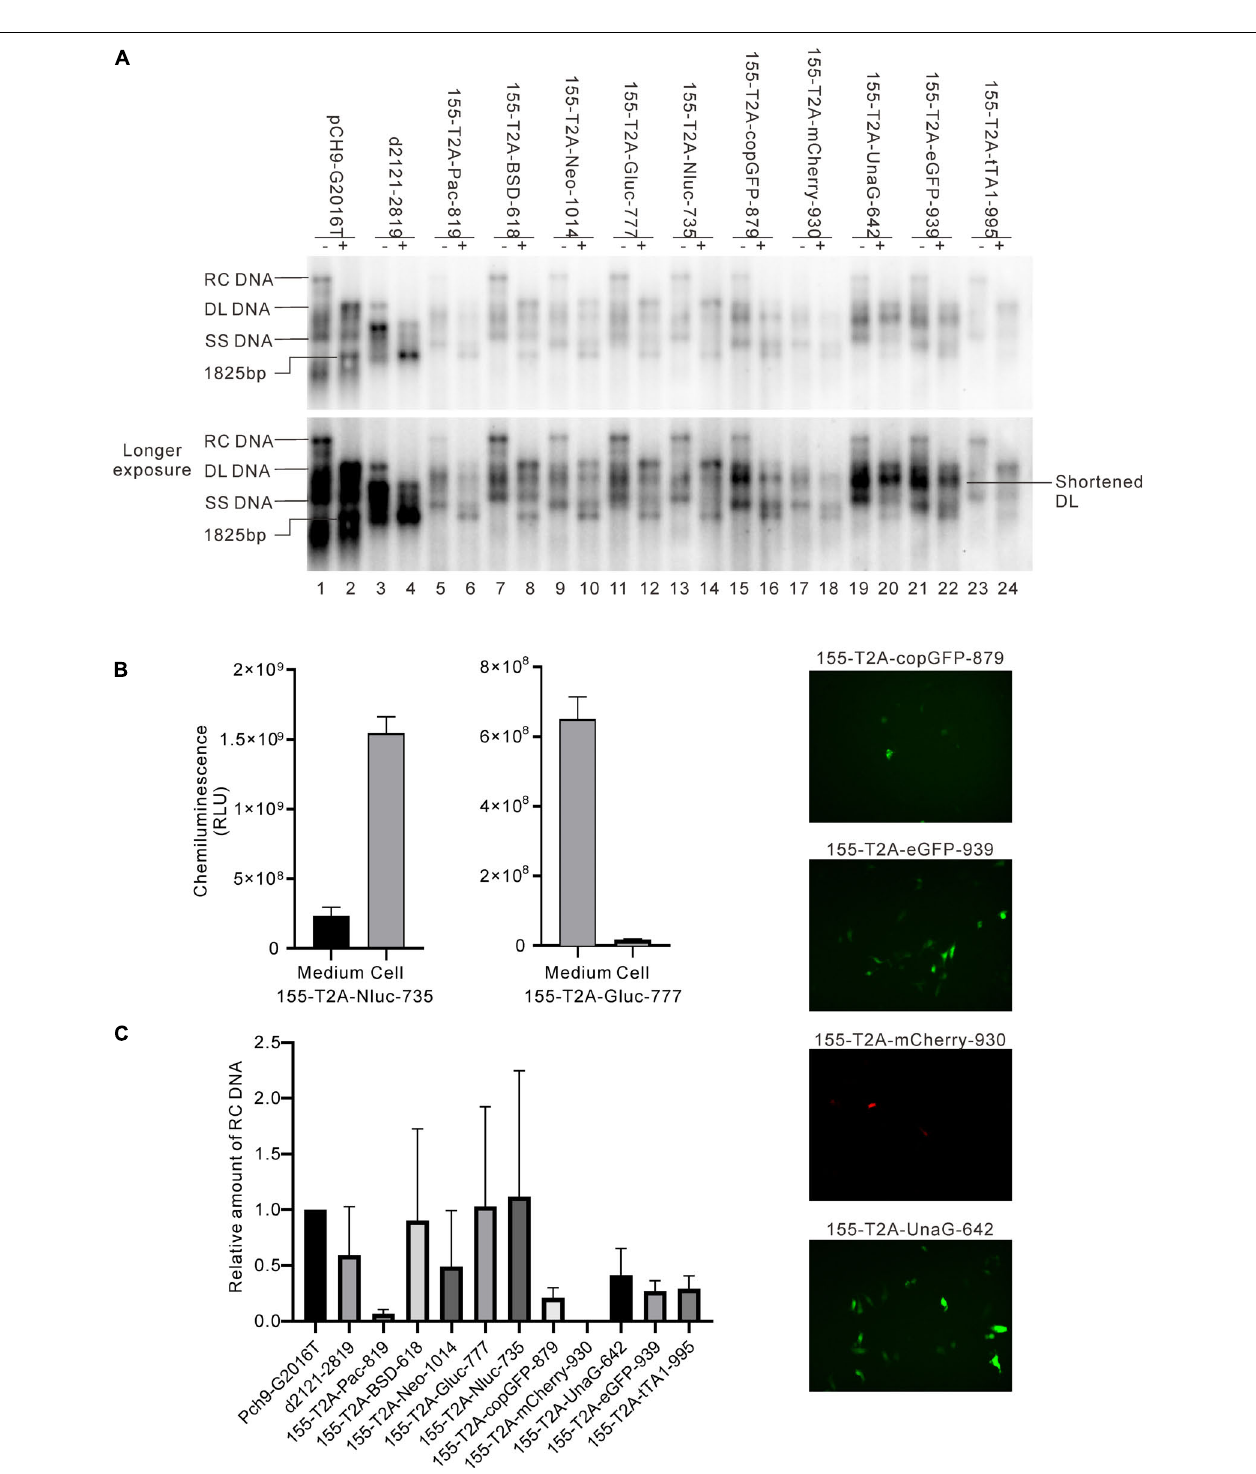
FIGURE 7 | Influence of the recombination at 155 on RC DNA formation. (A) A representative Southern blotting is shown. The plus sign (+) denotes Eco RI digestion. RC, DL, SS DNA, and Eco RI digested fragments are indicated. (B) Expression of the exogenous genes from the recombinants. Luciferase activity (Gluc and Nluc) or fluorescence (copGFP, eGFP, mCherry, and UnaG) was detected. (C) The relative intensity of RC DNA of the recombinants. The intensity of RC DNA of each sample was divided into the sum of RC DNA of all samples in the same membrane, respectively, to calculate the relative intensity of RC DNA of each sample. N = 4.